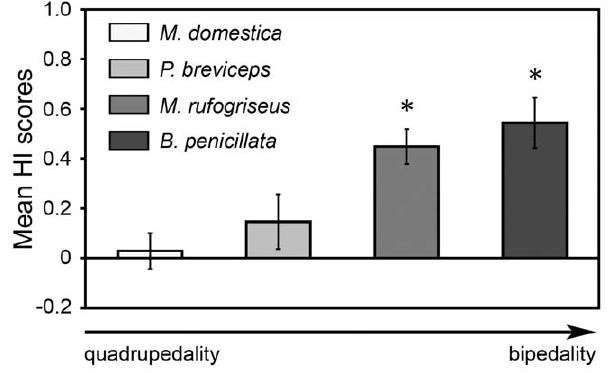
Figure 4. Comparative degrees of forelimb preferences at the group level in marsupial species characterized by different degree of bipedality. The bars represent mean HI scores 6 SEM for unimanual feeding on non-living food in grey short-tailed opossums, Monodelphis domestica ( n =26) [13], sugar gliders, Petaurus breviceps ( n =23) [13], red-necked wallabies, Macropus rufogriseus ( n =27) [49], and brush-tailed bettongs, Bettongia penicillata ( n =12) (the present study). Asterisks indicate that the mean HI score differed significantly from zero, * p , 0.05. The arrow indicates the increase of relative degree of bipedality and body verticality across marsupial species (see Fig.3 caption). The increase of bipedality across species corresponds with the increase of the degree of group-level